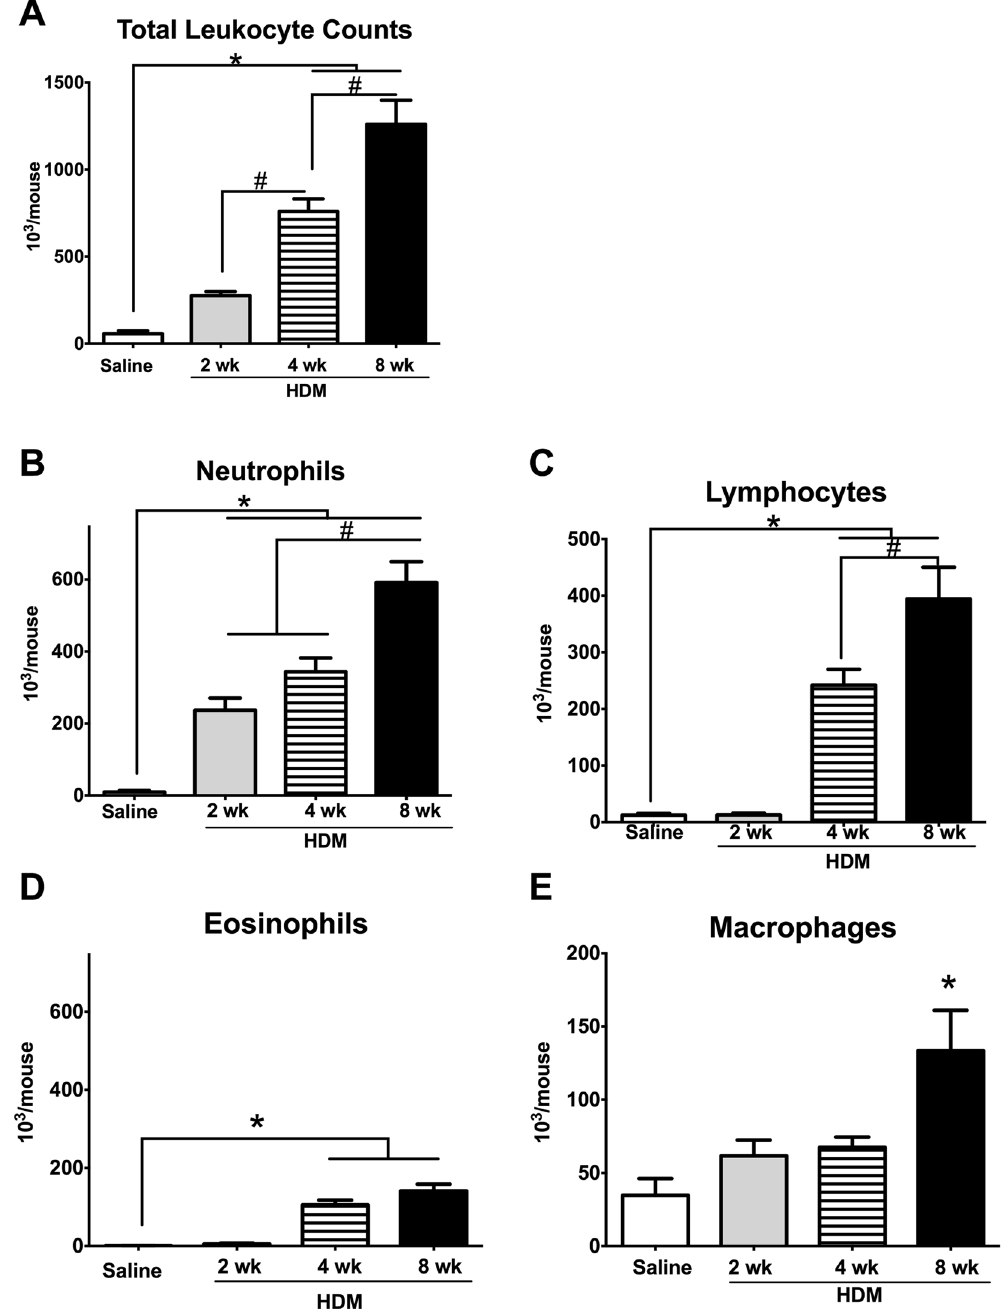
Figure 4. Increasing duration of HDM sensitization corresponds to increasing leukocyte recruitment to the airways. Total leukocyte counts in the BAL revealed a progressive increase in leucocyte recruitment with longer HDM exposures ( A ); * p < 0.05 vs Saline control, # p < 0.05 within HDM groups, n = 7/group). Differential leukocyte counts revealed that the leukocytosis was primarily due to increases in neutrophils ( B ), lymphocytes ( C ) and eosinophils ( D ), while BALF macrophages were increased only in 8-week HDM mice. ( E ) * p < 0.05 vs Saline control, # p < 0.05 within HDM groups, n =